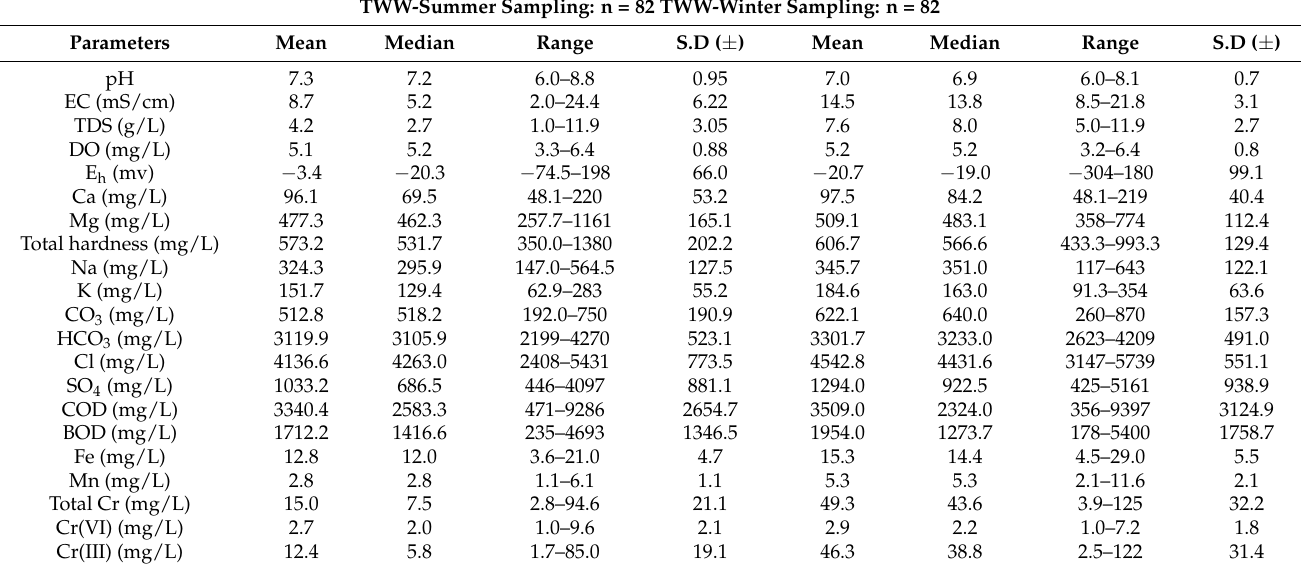
Table 1. Physico-chemical parameters of tannery wastewater collected in summer (TWW-summer) and winter (TWW-winter) seasons from the tannery industry area of Kasur, Punjab, Pakistan. TWW-Summer Sampling: n = 82 TWW-Winter Sampling: n = 82